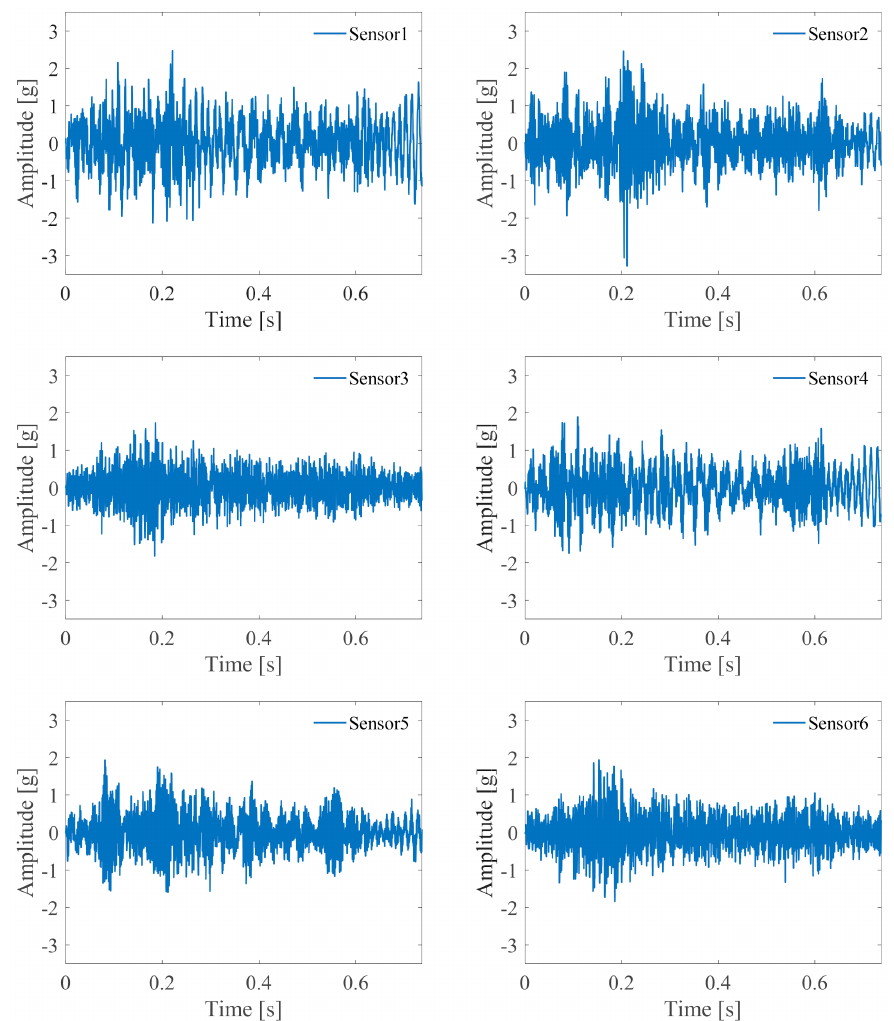
Figure 13. Processed signals in inner race fault